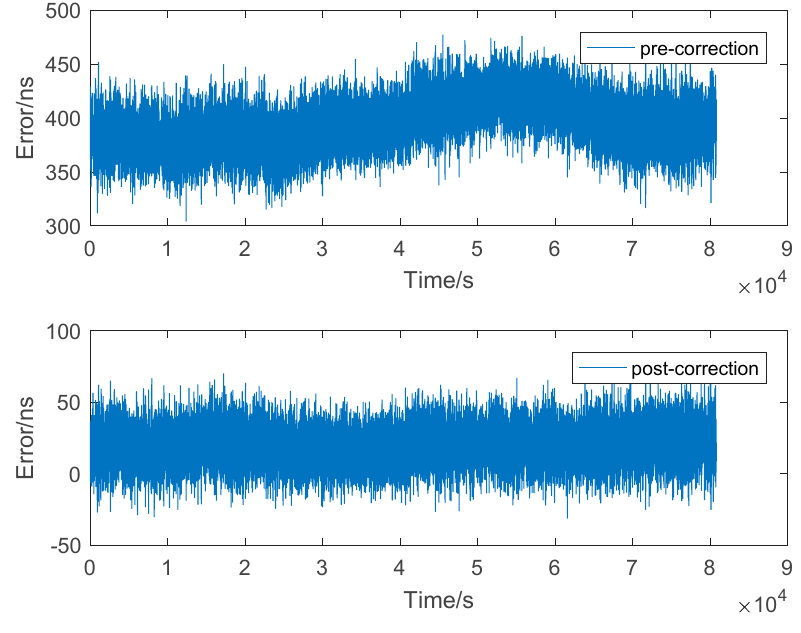
ff ect of di ff erence method in Figure 10. Effect of difference method in MX. Figure 10. E Figure 10. Effect of difference method in MX.